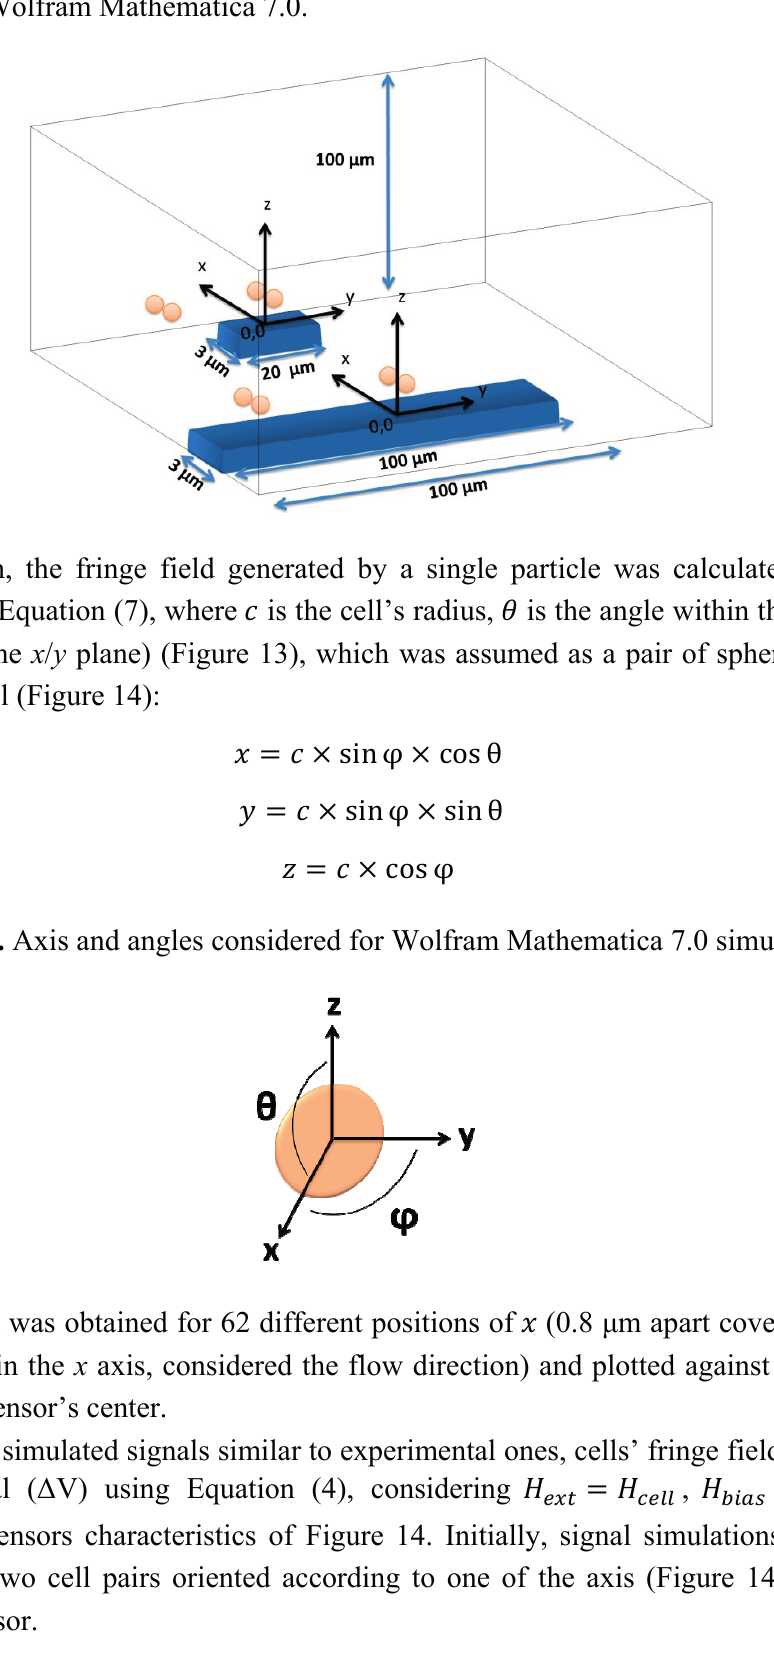
Figure 12. Schematics of sensor and channel geometry considered for output signal simulation in Wolfram Mathematica 7.0.